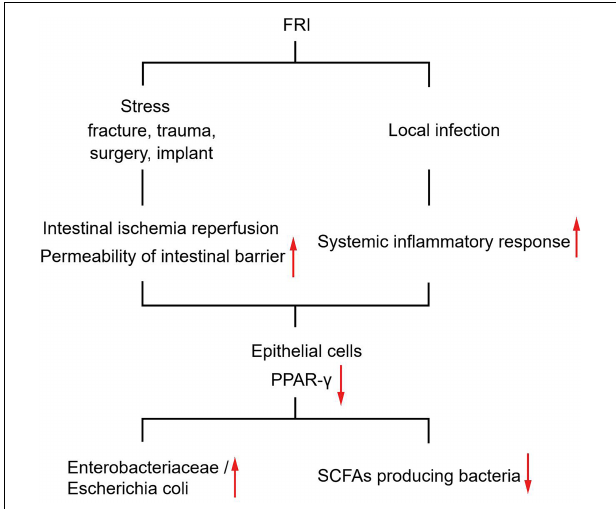
FIGURE 5 | Diagram of proposed mechanisms for gut microbiota changes induced by